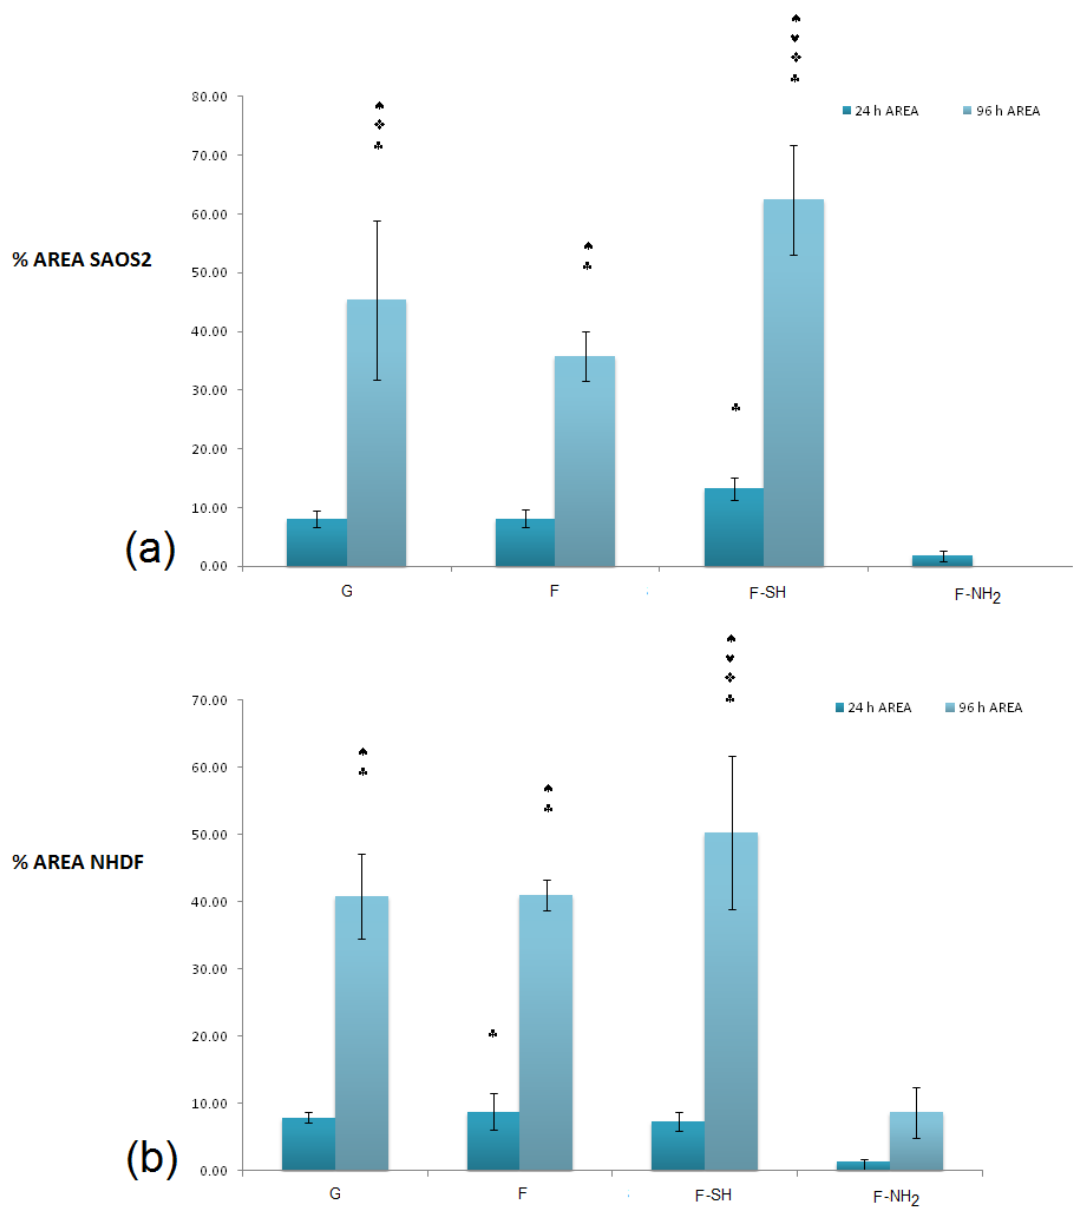
Figure 10. The % of substrate area covered by Saos-2 ( a ) and NHDF cells ( b ) grown on the different substrates after 24 and 96 h. Statistical differences among means were calculated by a two-way ANOVA test followed by a Bonferroni’s post-test: ♠ p < 0.01 vs 24h; ♥ p < 0.01 vs G; ♦ p < 0.01 vs F-SH; ♣ p < 0.01 vs F-NH 2 ; ✜ p < 0.01 vs F.